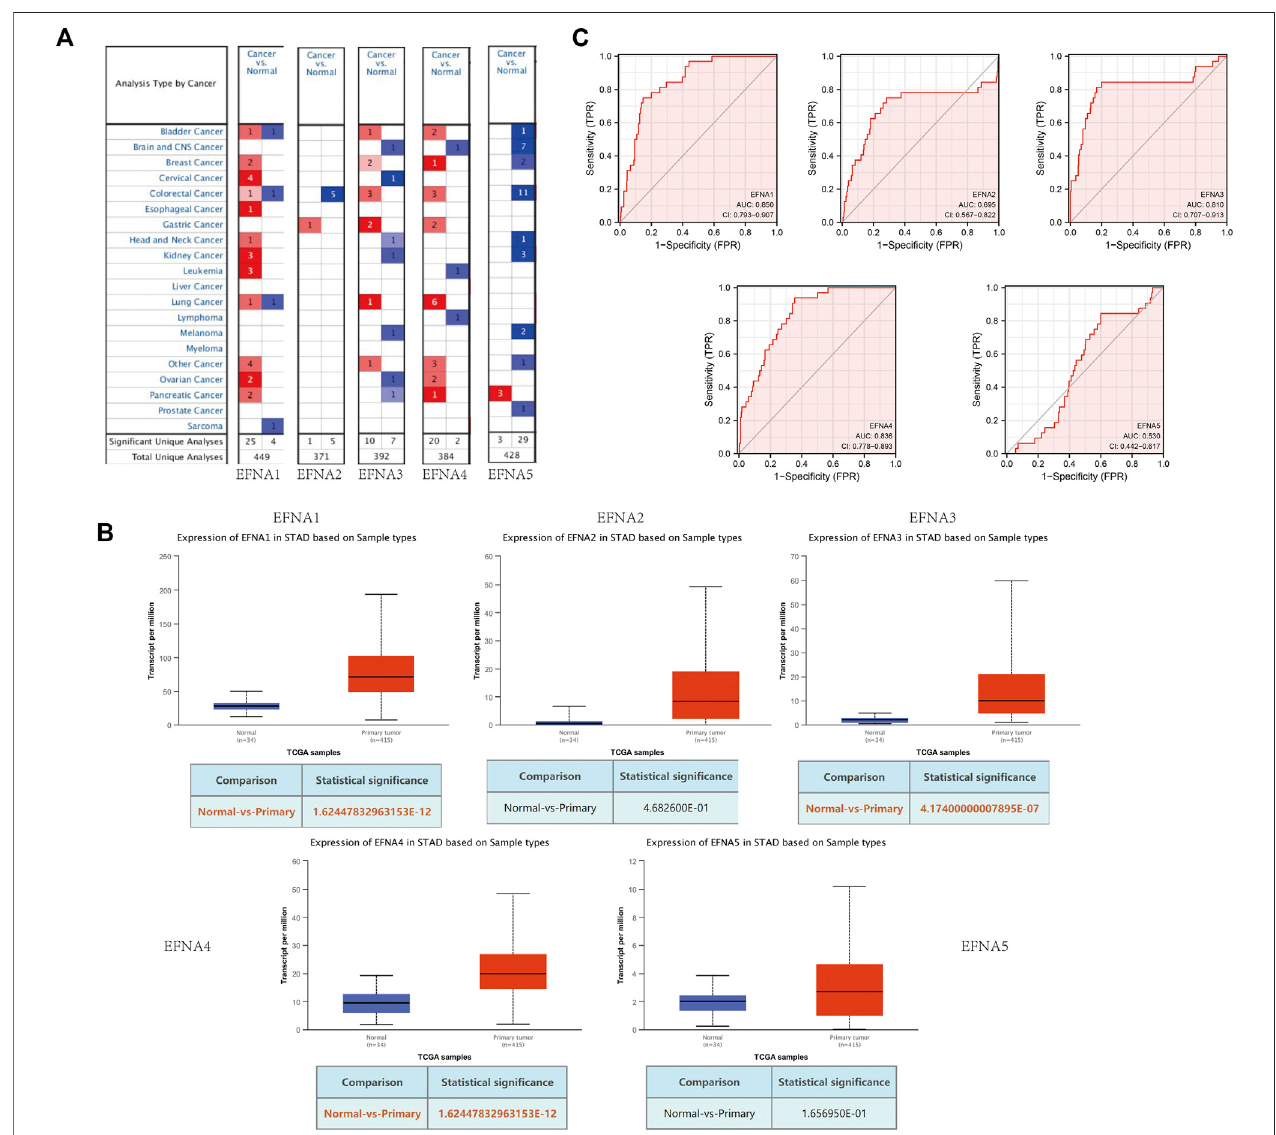
FIGURE 1 | Expression of EFNA1-5 in gastric cancer and normal tissues. (A) mRNA levels of EFNA in various cancers. Red represents up-regulated mRNA expression and blue represents down-regulated mRNA expression. (B) Transcription of EFNA1-5 in gastric cancer and normal tissues from UALCAN data. (C) ROC curves of the EFNA